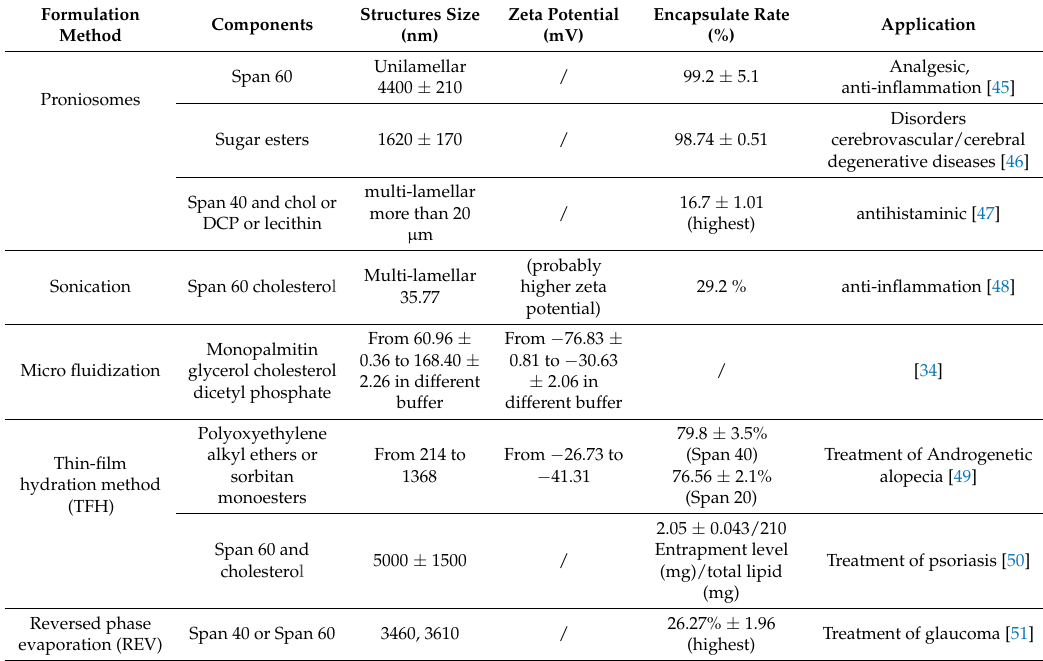
Table 1. Formulation method of niosomes.